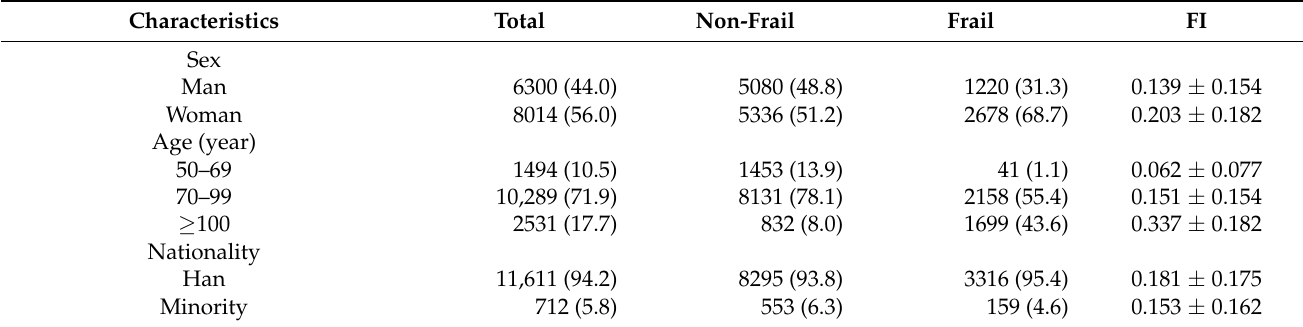
Table 1. Basic characteristics of the